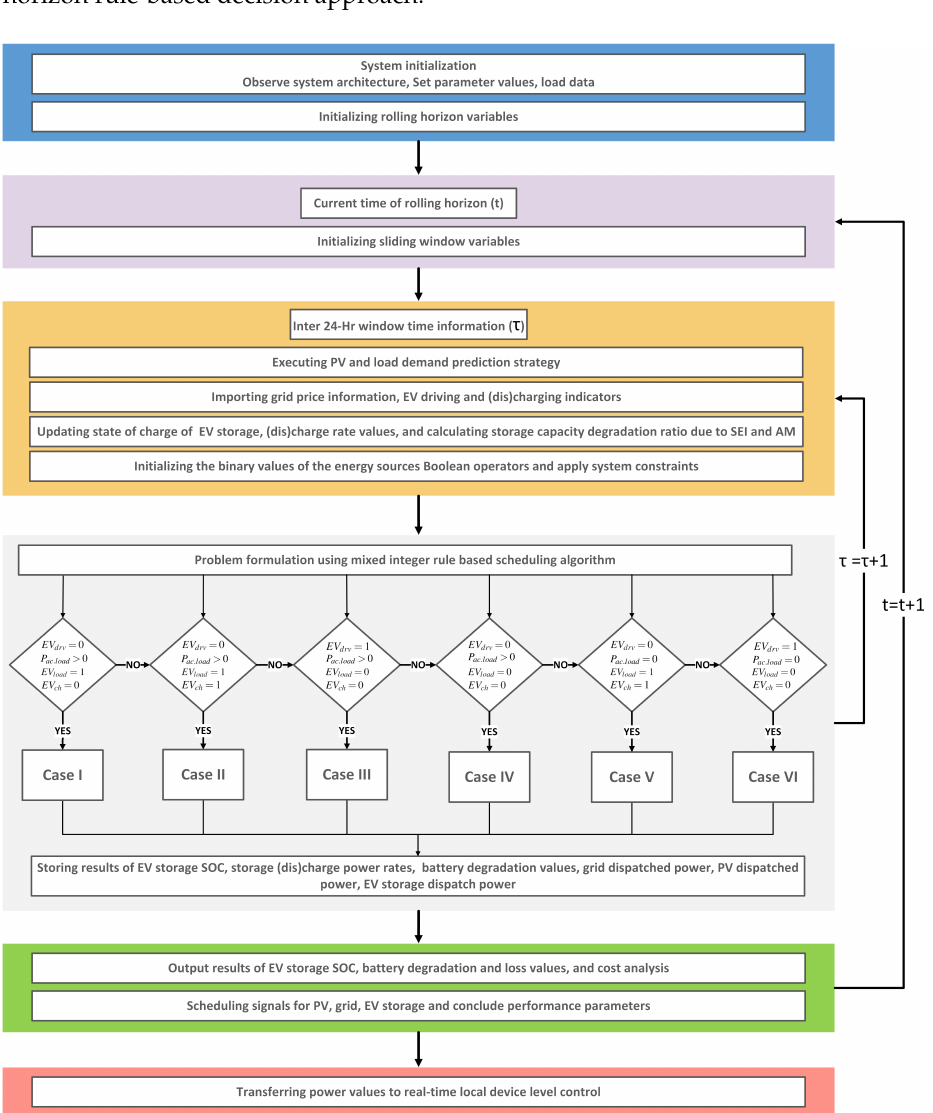
Figure 5. Flowchart of the proposed scheduling scheme